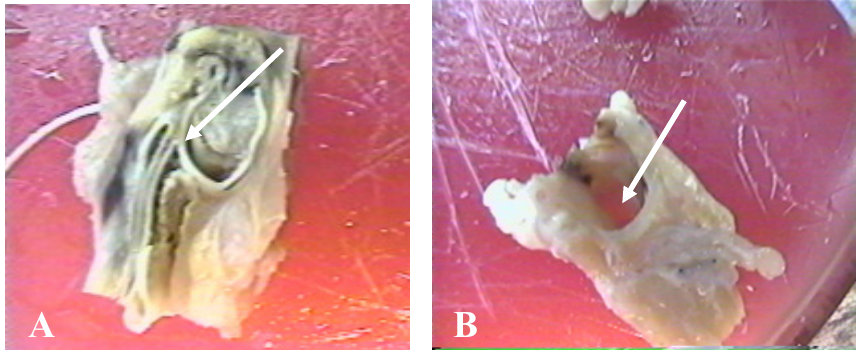
FIGURE 4 - Fragments of the specimen removed on the 28th postoperative day from the right inguinal region of dog no. 4: A – The latex biomembrane with impermeable polyamide is tortuous (arrow). B - cyst (arrow)